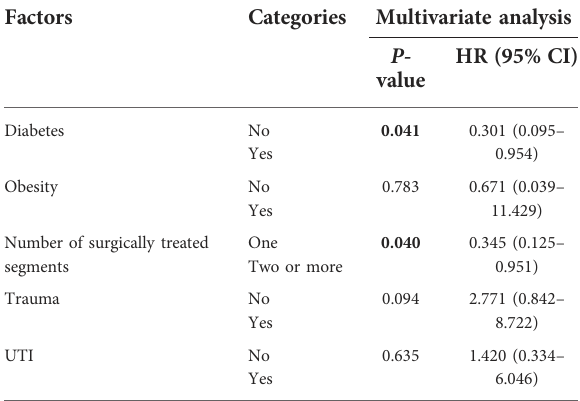
TABLE 7 Multivariate logistic analyses of risk factors for NTS after PVP/PKP.